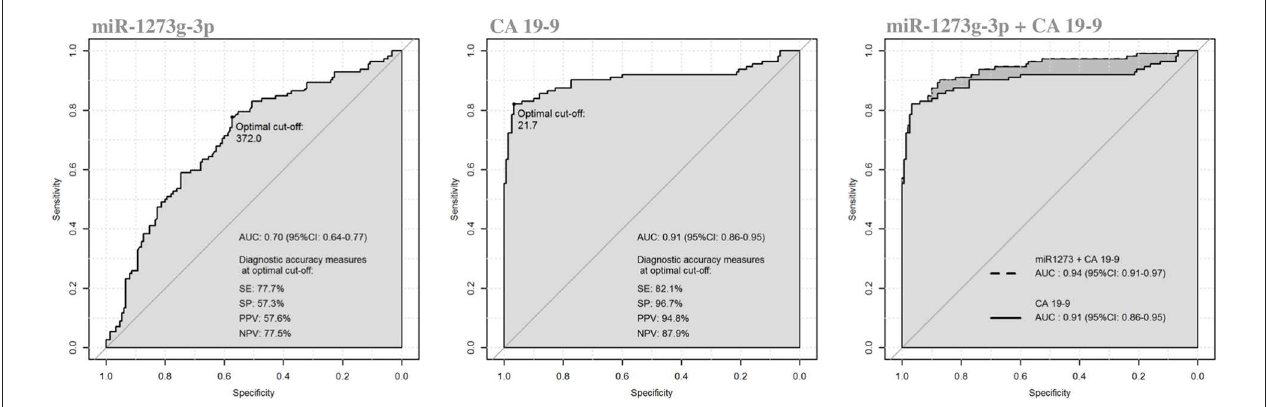
FIGURE 4 | Receiver operating characteristics (ROC) curve analysis of miR-1273g-3p and CA 19-9 in discriminating patients with pancreatic cancer from healthy subjects. significant over-expression of miR-122-5p, miR-1273g-3p, and miR-6126 in PanC compared to HS, in line with the trend of the CA 19-9 levels. Conversely, no significant difference in